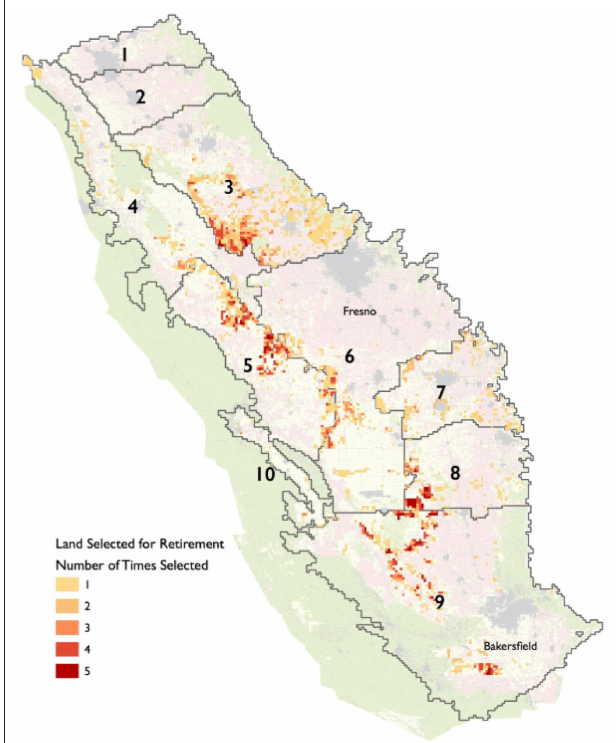
FIGURE 4 | Number of times each pixel was selected for retirement under BAU SGMA across the five LUC scenarios. The figure highlights several “hotspot” clusters where retirement is likely regardless of the key determinants of suitability. Note that the total area identified as retired under each scenario is smaller than the visual footprint of heatmap pixels. This is due to (1) imperfect overlap of all five scenarios, and (2) pixels are counted as retired if any agricultural land existing within the pixel was retired, which could only be a fraction of the total pixel area (the fraction of the pixel retired is tracked throughout our analysis